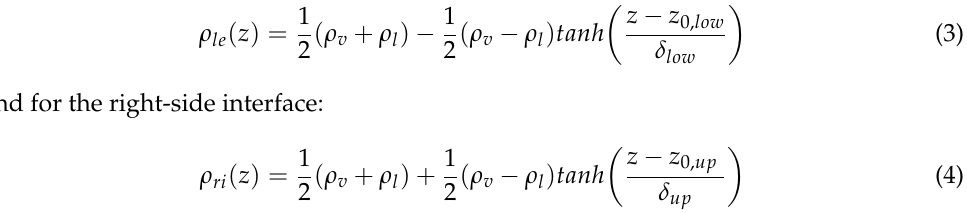
Figure 2. Phase equilibria simulation snapshot at a random moment of time. The periodic boundary conditions are applied to x , y and z axes.